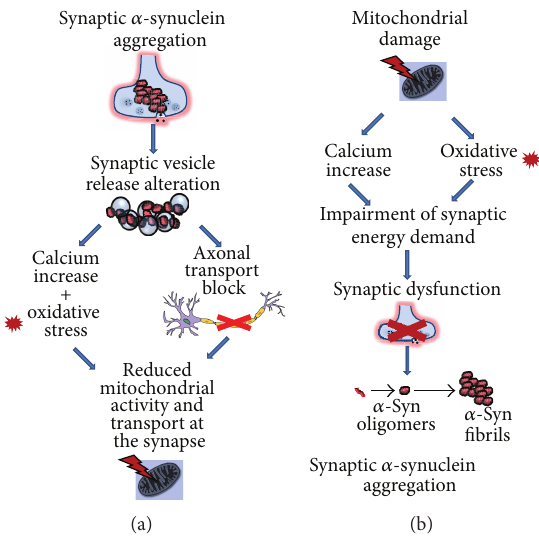
Figure 1: Hypothetical schematic representation of the two possible series of molecular events intervening either between synaptic 𝛼 - synuclein deposition and the induction of mitochondrial dysfunction (a) or between mitochondrial functional deficits and accumulation of 𝛼 -synuclein at the synapse (b). Please note that in both of the two situations, Ca 2+ rise and production of oxidative stress mediators are pivotally involved in the interconnection between mitochondrial impairment and 𝛼 -synuclein synaptic